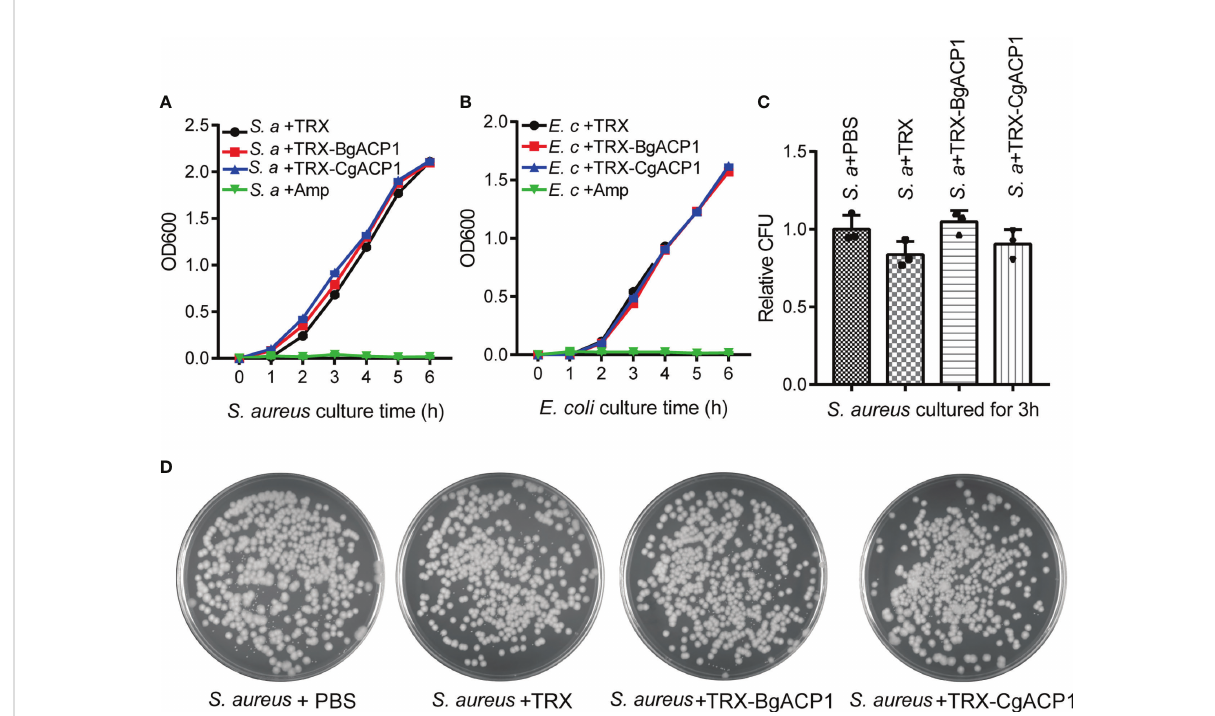
FIGURE 6 Recombinant CgACP1 and BgACP1 showed no inhibiting or killing activity to bacteria S. aureus and E. coli. Growth curves of S. aureus (A) and E . coli (B) in the presence of TRX-CgACP1 or TRX-GgACP1. 200 m g/ml of each ACP, Ampicillin (Amp) or TRX (as control) were incubated with the indicated bacteria and the OD 600 was measured every 1 hour after starting the culture (mean ± SD, n = 3). (C) Mollusk ACPs did not affect the colony forming unit (CFU) of S. aureus. 200 m g/ml of each ACP or TRX (control) were incubated with the S. aureus for 3 hours and the numbers of bacteria were determined by colony counts. Relative CFU represents the ratio of CFU incubated with TRX/ACP and incubated with PBS. One of the three petri dishes used in (C) is shown in (D)